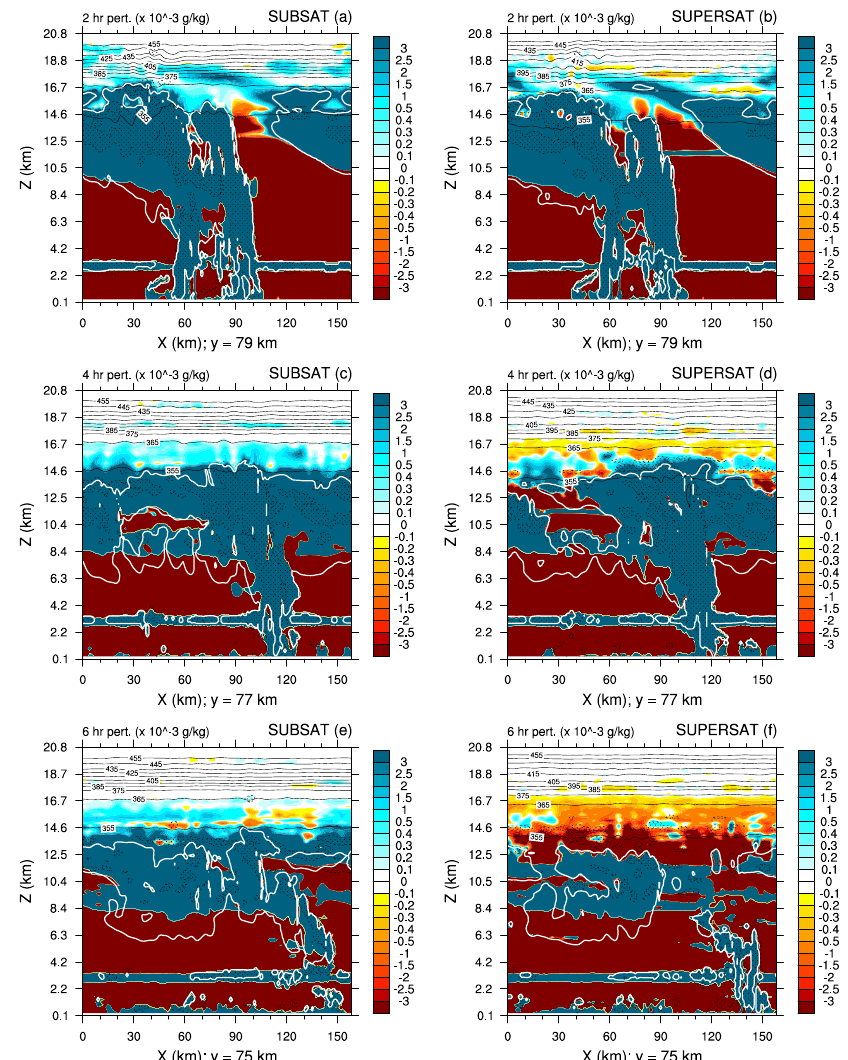
Fig. 10. Vertical cross-sections of total water perturbation for (a, c, e) SUBSAT and (b, d, f) SUPERSAT cases, taken at 2h intervals along y = 79, 77 and 75km, respectively. Potential temperatures isolines, contoured every 10K between 355–455K, are overlaid. The thick white line represents the total cloud mixing ratio of 0.01gkg − 1 . Stippled regions correspond to where parameterised TKE per unit mass exceeds 0.05m 2 s − 2 to indicate non-zero mixing within and near the cloud